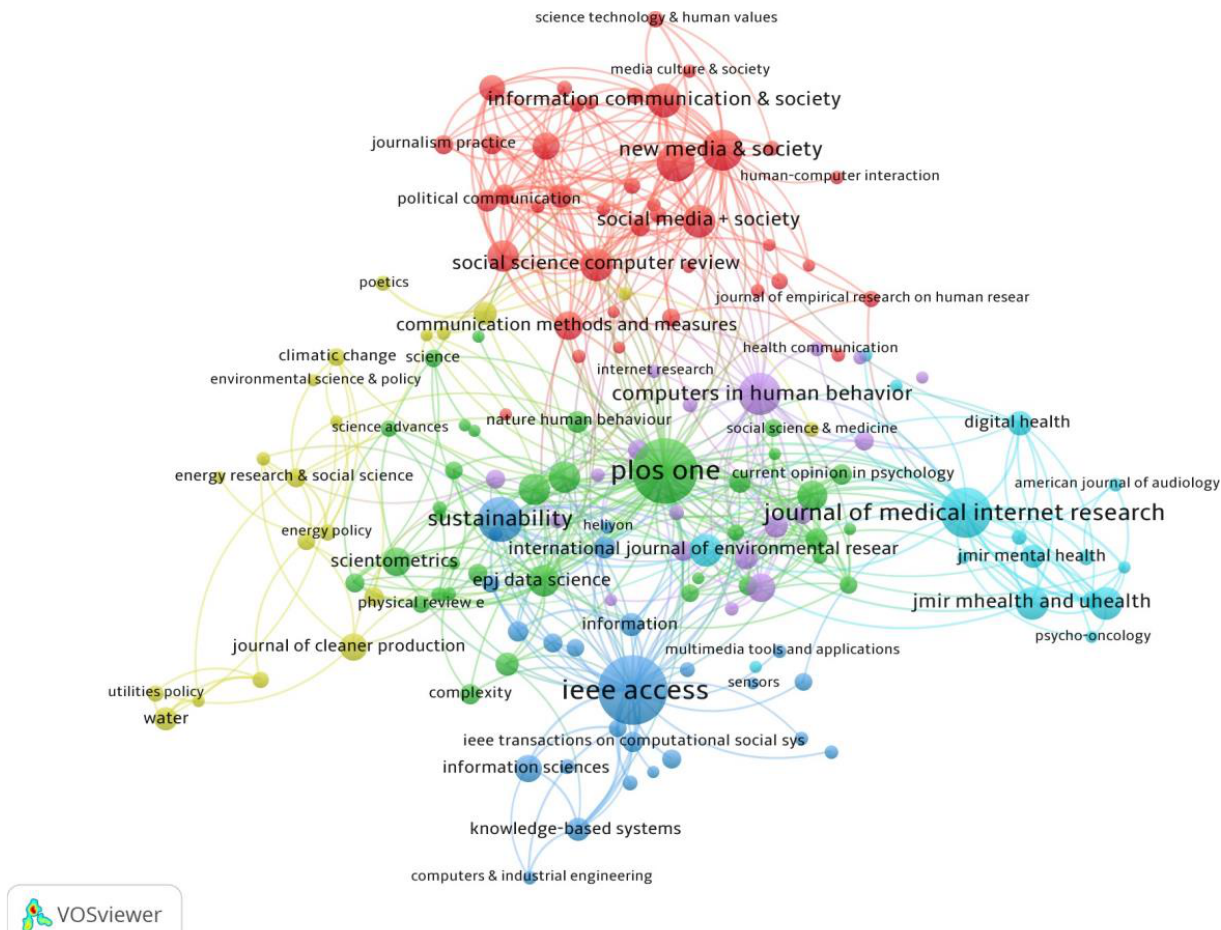
Figure 7. Citation impact environment of CSS, based on WoS, Citing CSS dataset.